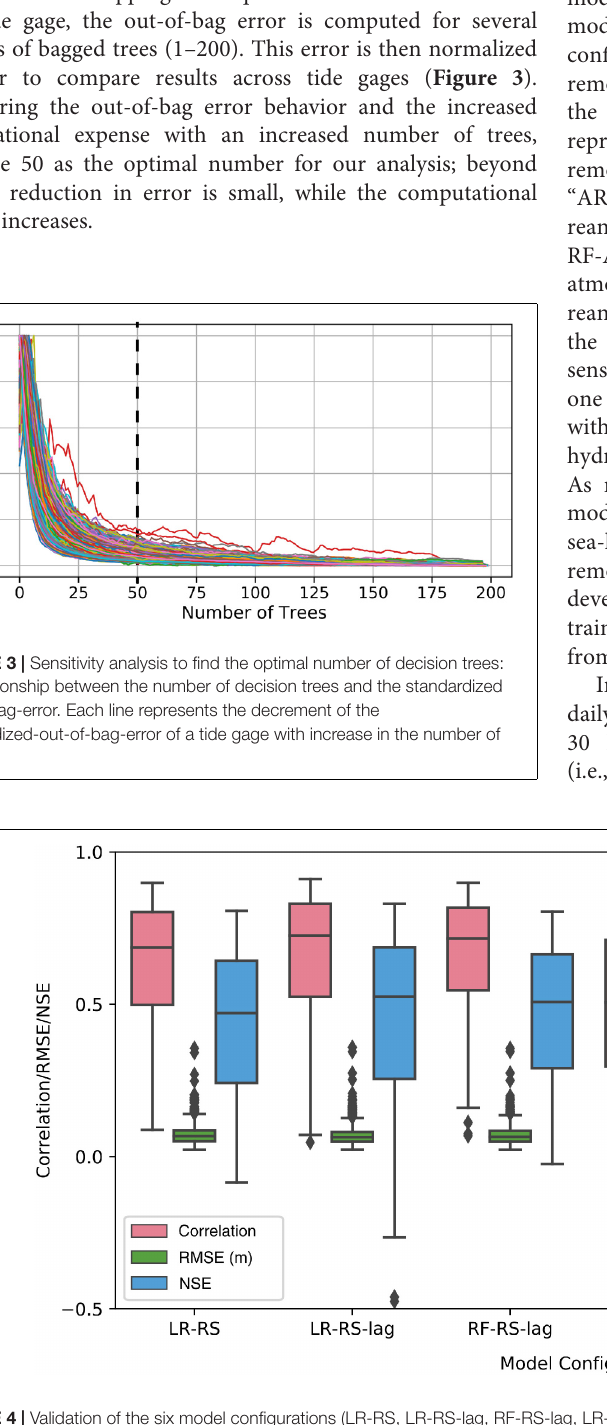
Frontiers in Marine Science |